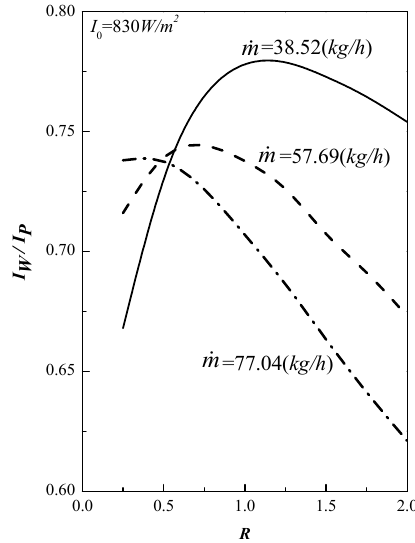
Figure 7. Effects of recycle ratio and air mass flow rate on the value of I W / I P .